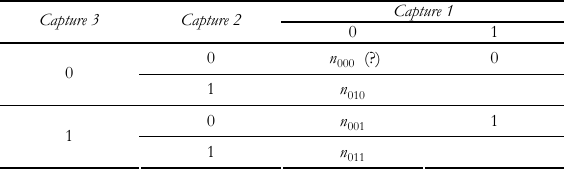
Representation of 3 sources Capture-Recapture data by a contingency-table